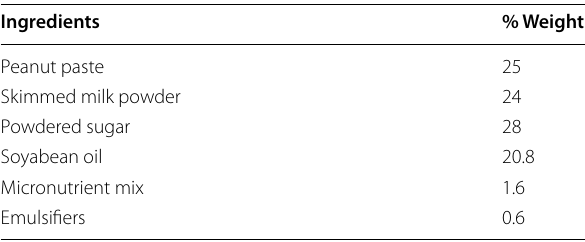
Table 1 Composition of medical nutrition therapy MNT (RUTF) (Jadhav et al. 2016)